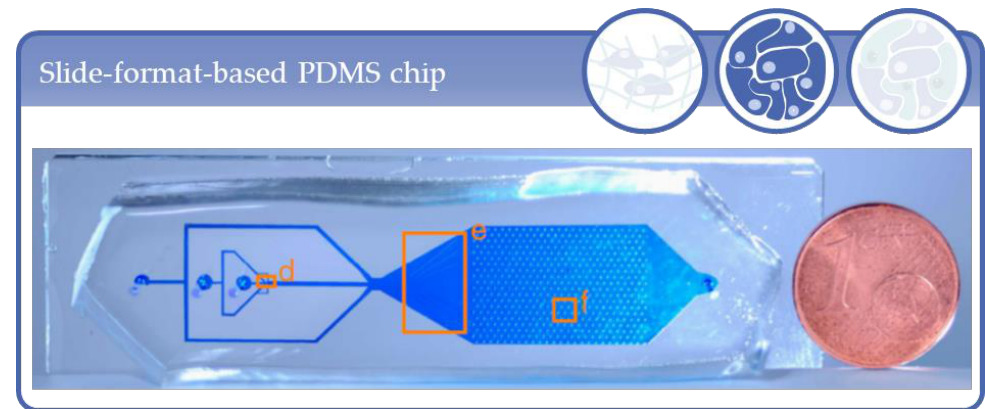
Figure 12. Slide-format based PDMS chip for on-chip generation of spheroids and integrated multiscale cytometry. Reprinted from Sart et al., Nat. Commun. 2017; 8(1):469 [119].